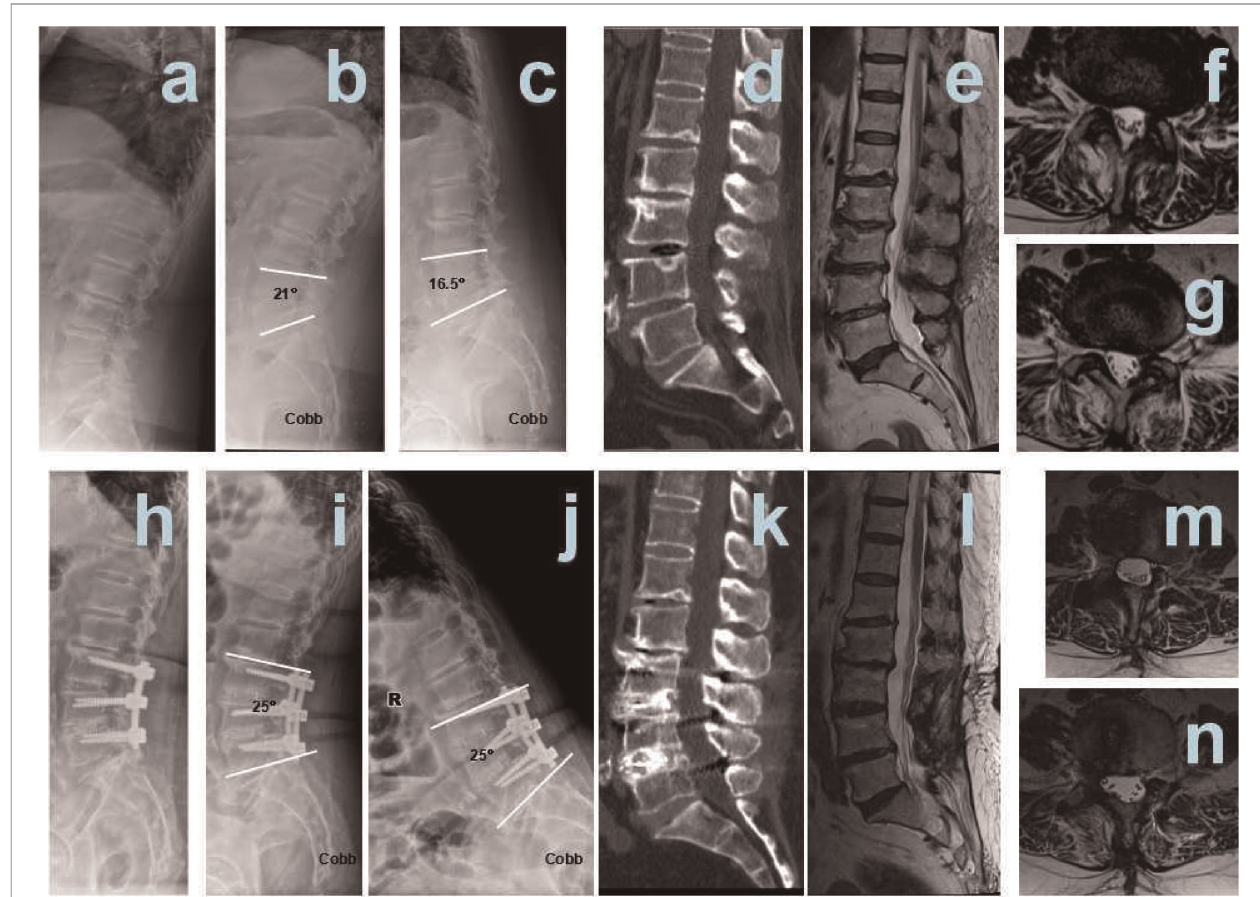
FIGURE 5 | TLIF patient 1. ( A ) Pre-surgical lateral X-ray; ( B ) pre-surgical hyper-extension X-ray; ( C ) pre-surgical hyper- fl exion X-ray; ( D ) pre-surgical CT showed L3/4, L4/5 spinal stenosis; ( E ) pre-surgical T2 weighted MRI sagittal plane showed L3/4, L4/5 spinal stenosis; ( F ) pre-surgical MRI showed L3/4 spinal stenosis; ( G ) pre- surgical MRI showed L4/5 spinal stenosis; ( H ) 12 months after surgery, post-surgical lateral X-ray; ( I ) 12 months after surgery, post-surgical hyper-extension X-ray; ( J ) 12 months after surgery, post-surgical hyper- fl exion X-ray; ( K ) 12 months after surgery, post-surgical CT showed interbody fusion; ( L ) 12 months after surgery, post-surgical T2-weighted MRI sagittal plane; ( M ) 12 months after surgery, post-surgical MRI sagittal plane showed that L4/5 spinal stenosis was improved signi fi cantly; and ( N ) 12 months after surgery, post-surgical MRI sagittal plane showed that L5/S1 spinal stenosis was improved signi fi